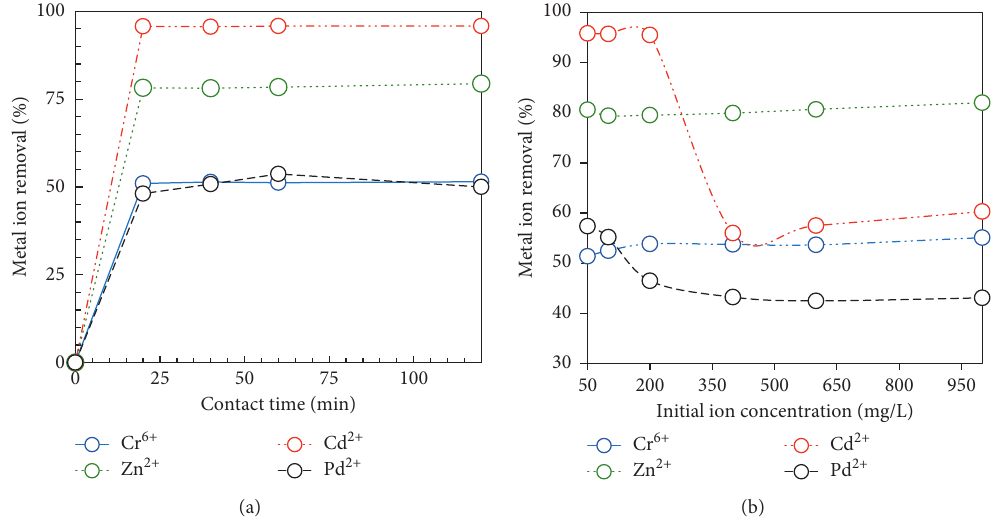
Figure 7: Metal ion removal (%) as a function of the (a) contact time (initial concentration 100 mg/L, pH 6, room temperature, 25mL solution, 5 mg MMFC) and (b) initial ion concentration (contact time 60min, pH 6, room temperature, 25mL solution, 5mg MMFC). The lines are added as guides to the